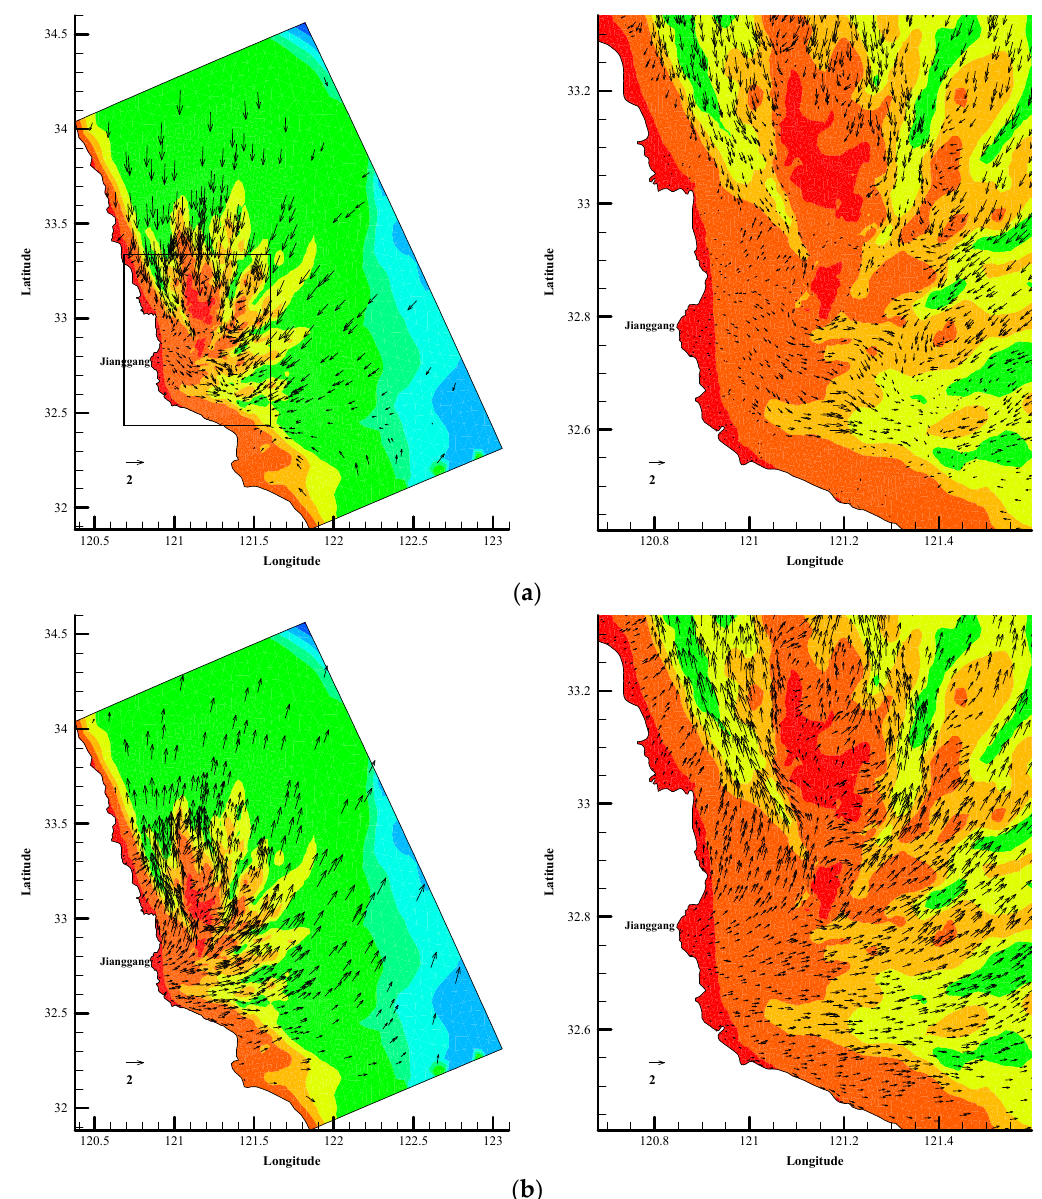
Figure 7. Maximum flood and ebb current fields when the natural RSRs are present (the base map shows the topography: left is the global tidal current field and right is the local tidal current field); ( a ) Maximum flood; ( b ) Maximum ebb.